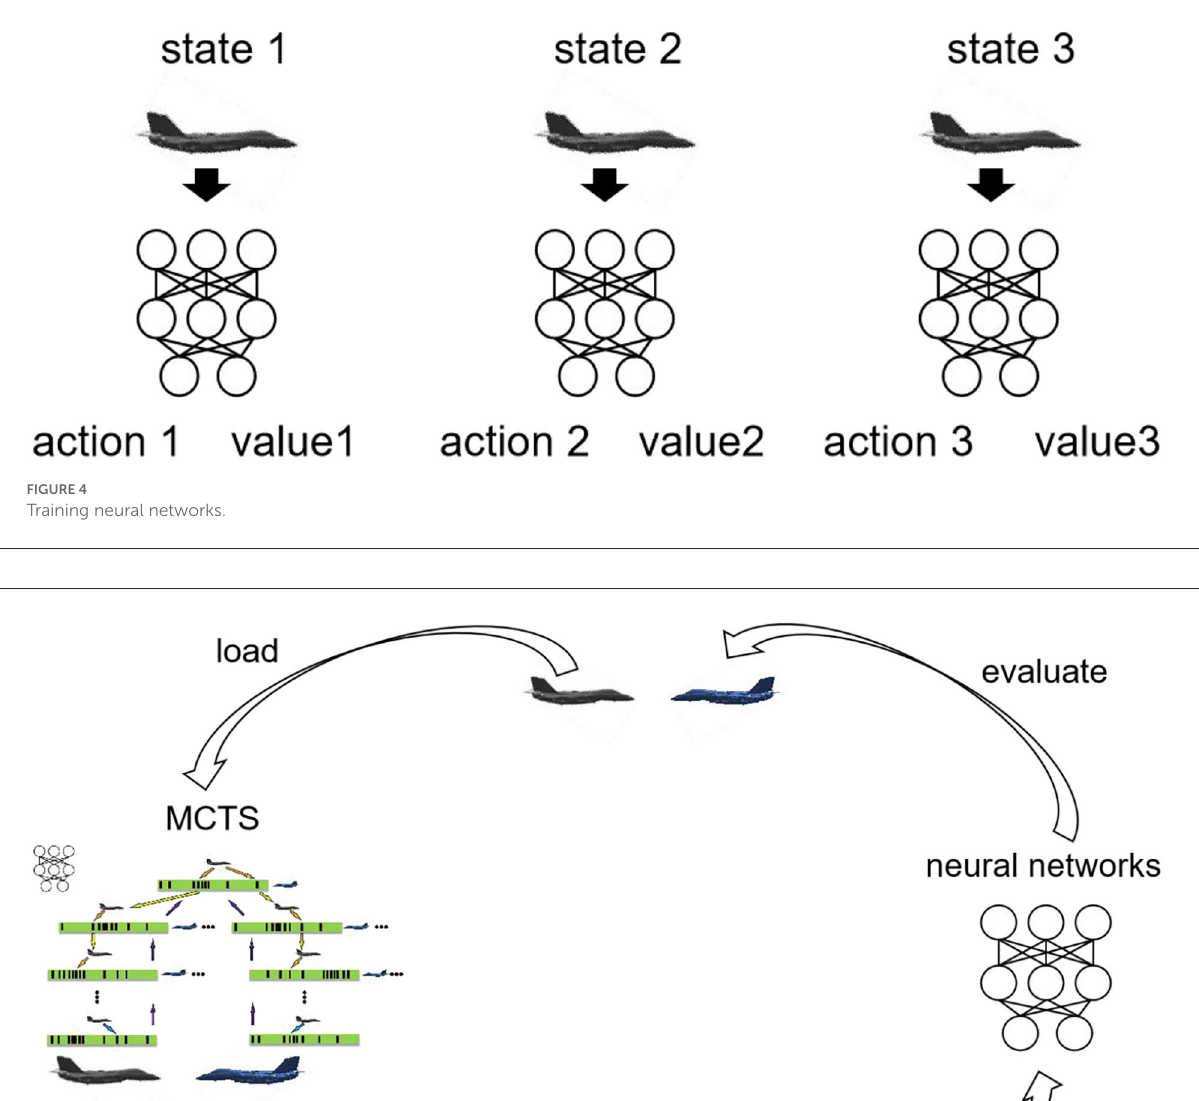
Figure 5 indicates the whole procedure of agent